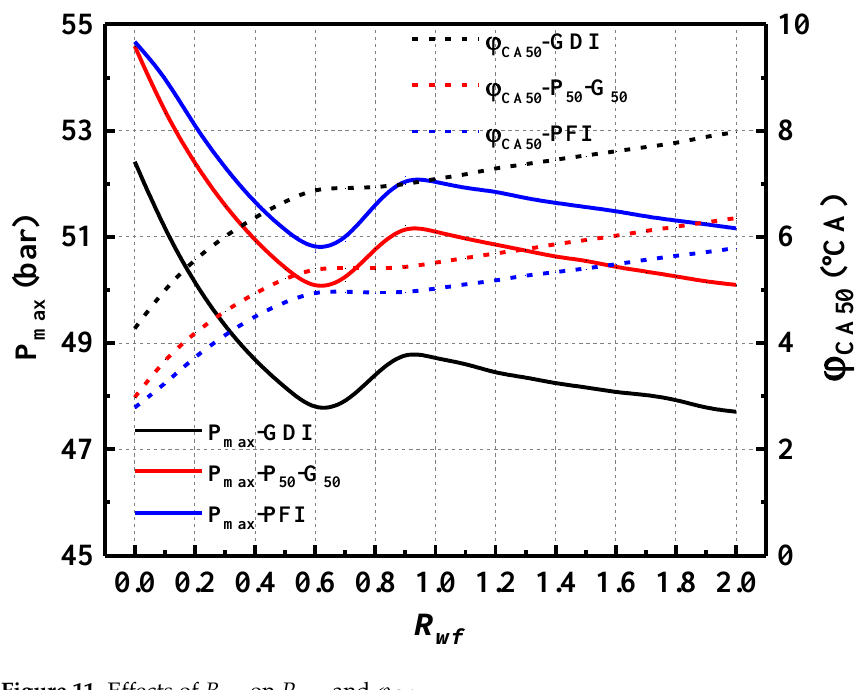
Figure 11. Effects of 𝑅 𝑤𝑓 on 𝑃 𝑚𝑎𝑥 and 𝜑 𝐶𝐴50 .